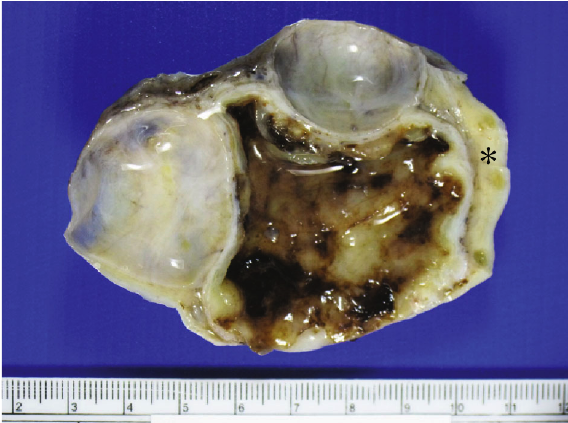
Figure 1: Cut surface of the ovary shows three cystic lesions which are well-demarcated from the remaining ovarian parenchyma (asterisk). The largest locule has nodular white lining with focal hemorrhage, whereas the other two locules show smooth internal